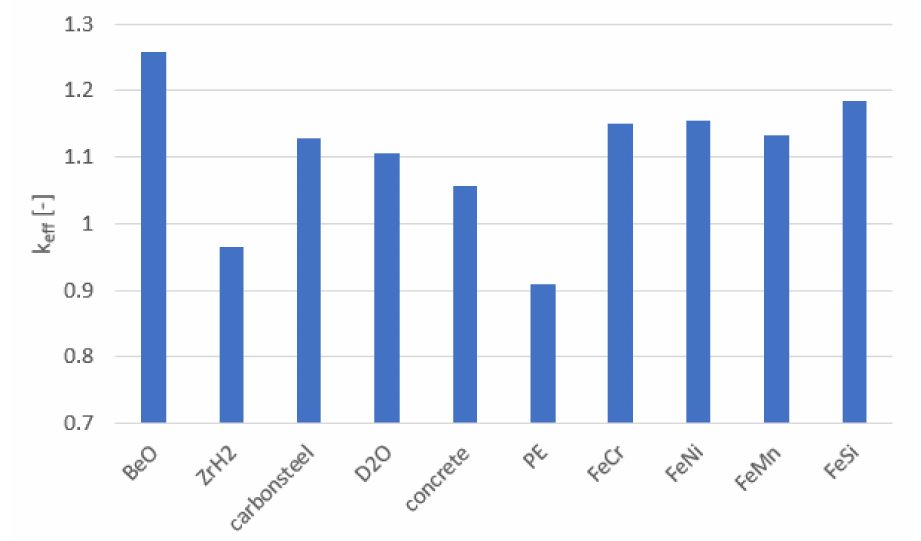
Figure 5. Analysis of the effect of a 30 cm thick reflector made from different, more exotic materials on the criticality of the studied 2D test